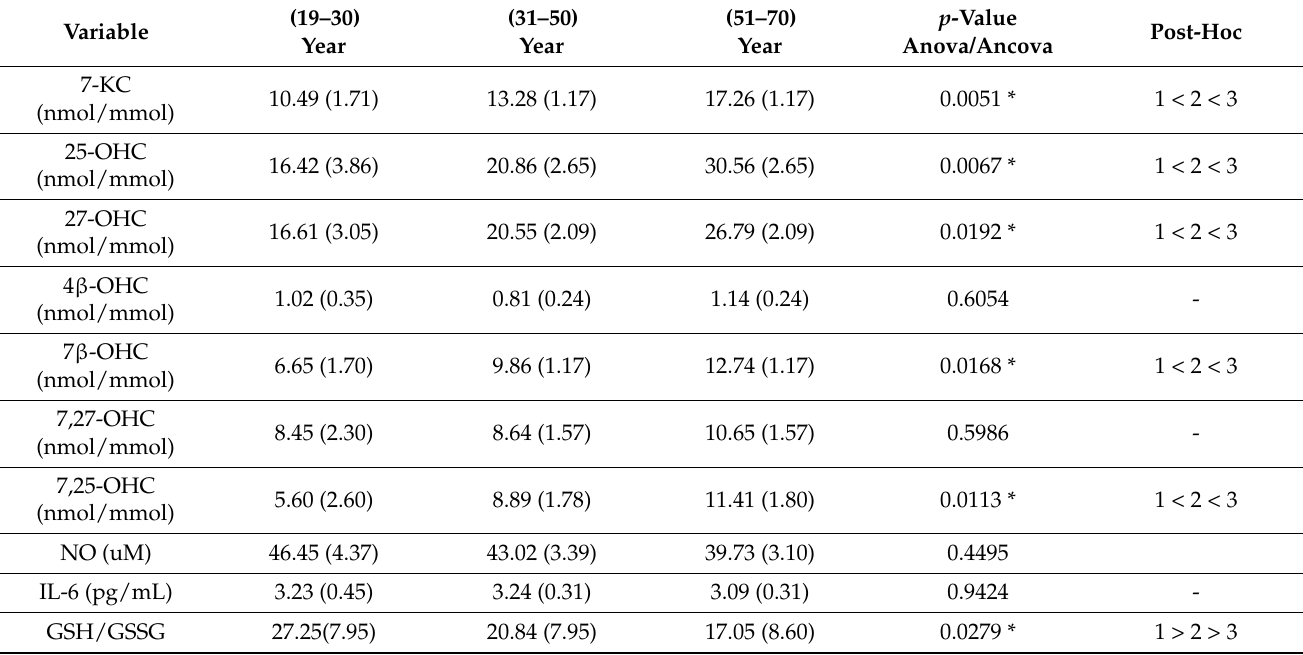
Table 4. Summary of normalized oxidative stress and inflammatory systemic circulatory